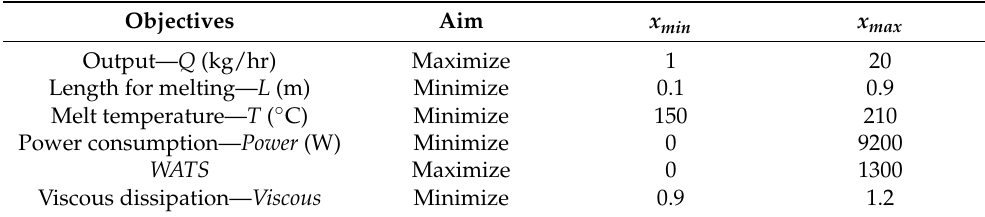
Table 2. Optimization objectives, aim of optimization and range of variation. Objectives